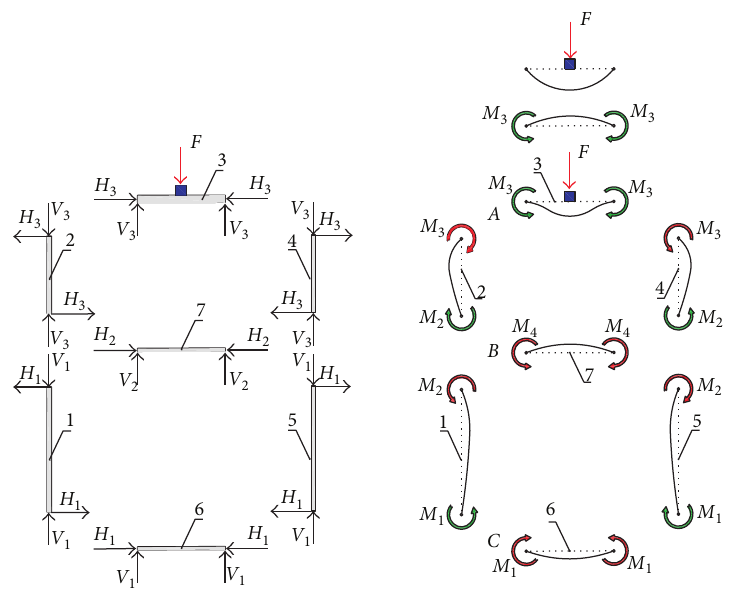
Figure 2: Internal reaction forces and moments of two-cell box